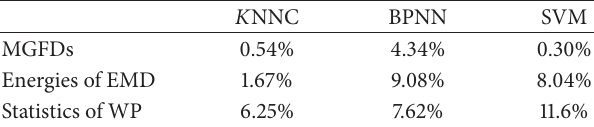
Table 1: The classification error rates of pattern